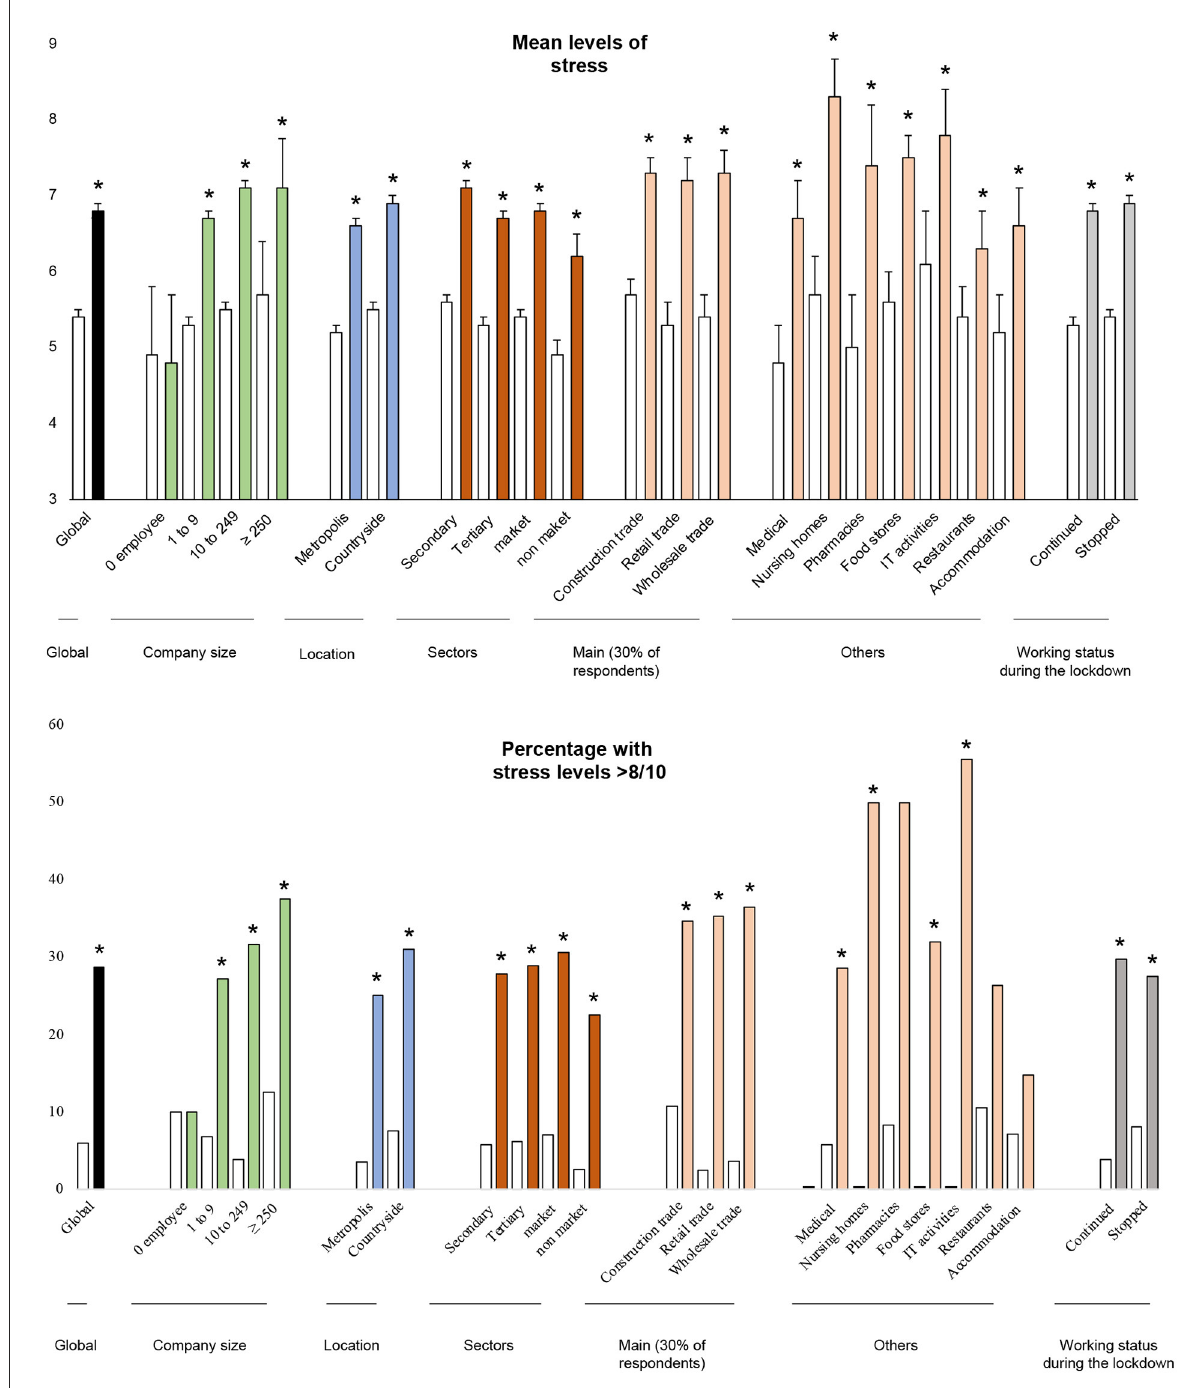
FIGURE4 Stress before and during lockdown (mean levels ± standard error of the mean). Light shading: before the lockdown; Dark shading: during the lockdown. *: significant changes within the condition ( p < 0.05) between before and